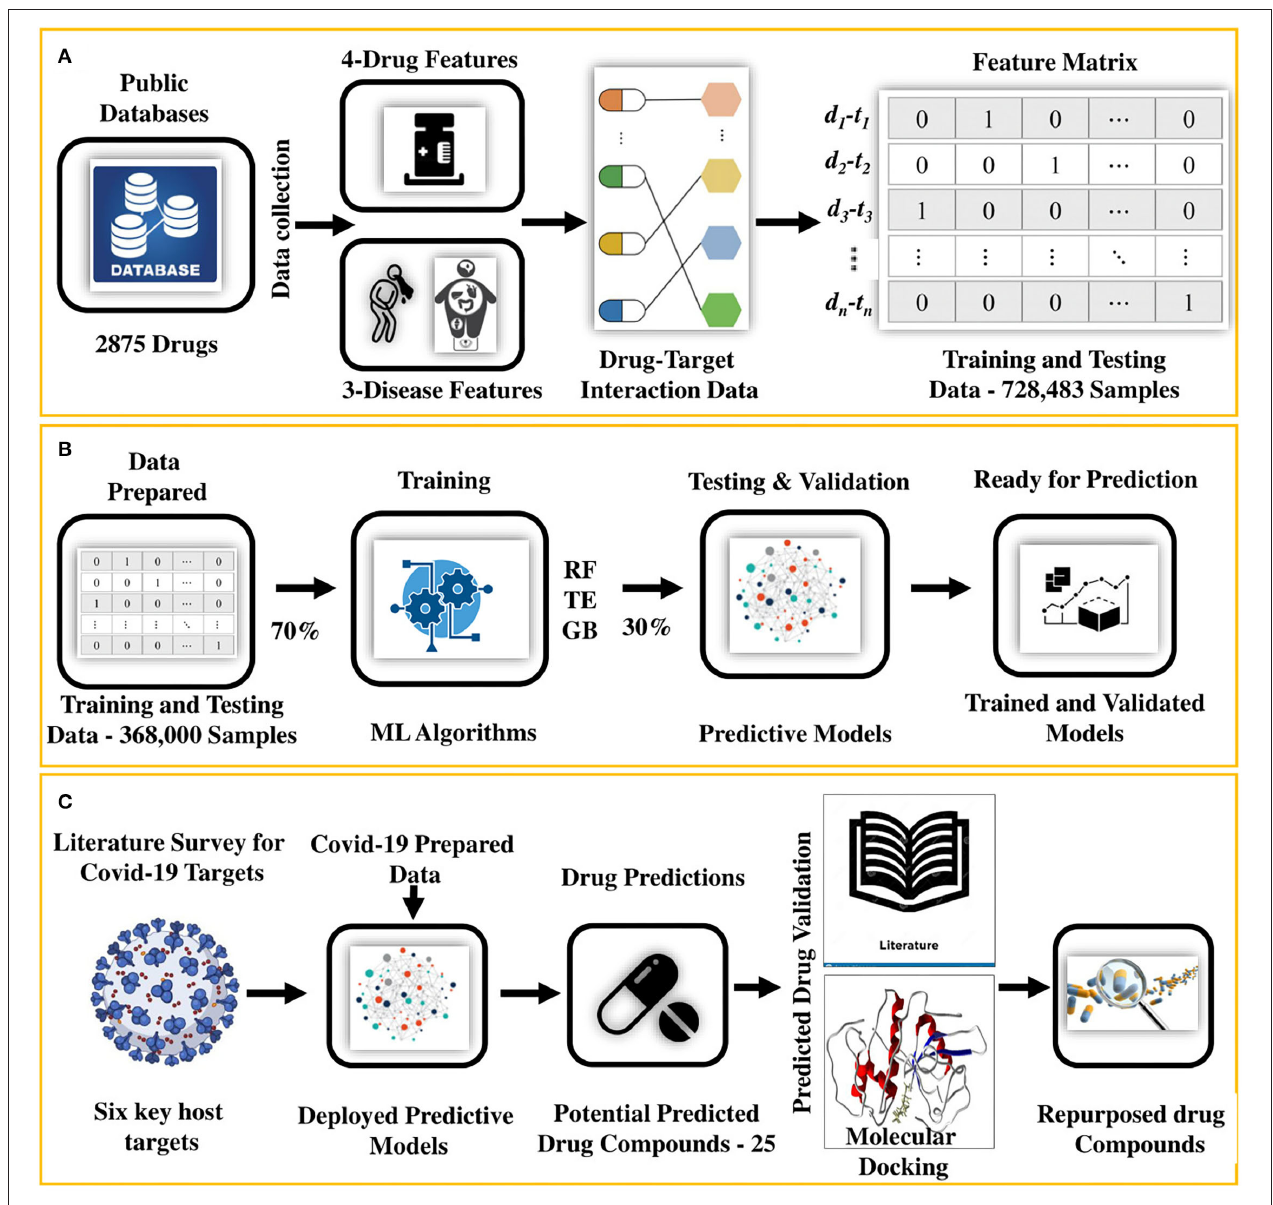
FIGURE 1 | An integrated machine learning and molecular docking-based ensemble approach for drug repurposing. (A) It shows that the drug and disease data collected from the public databases are first arranged and then transformed into a feature matrix, (B) followed by training and testing of the predictive models (RF and TE). (C) After training and testing, the data for the COVID-19 host targets are prepared from the literature review and fed to the predictive model for getting the potential repurposed drugs. Potential hits are then validated by using literature mining and collecting the evidence in the form of papers, patents, and database evidence. For the remaining predictions, molecular docking is performed to find the binding affinity of the drugs. Finally, the drugs with the highest binding affinity are prioritized as the potential repurposed candidates ready for the preclinical and clinical